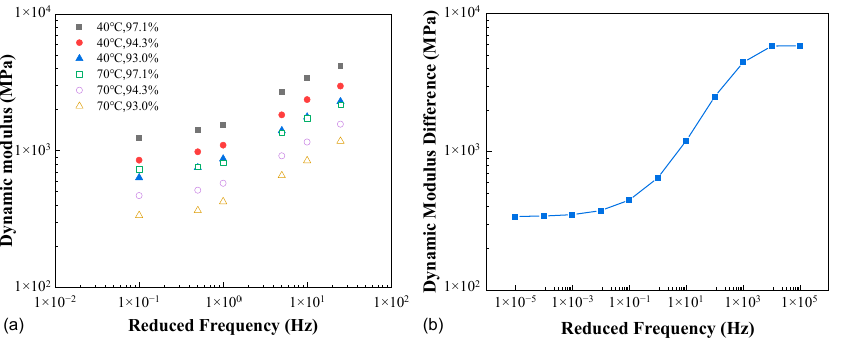
Figure 9. Functional dependence of the vertical shift factor (AC-20): ( a ) the modulus master curves at different compactness and temperatures, and ( b ) the modulus difference between the compactness of 97.1% and 93.0%.